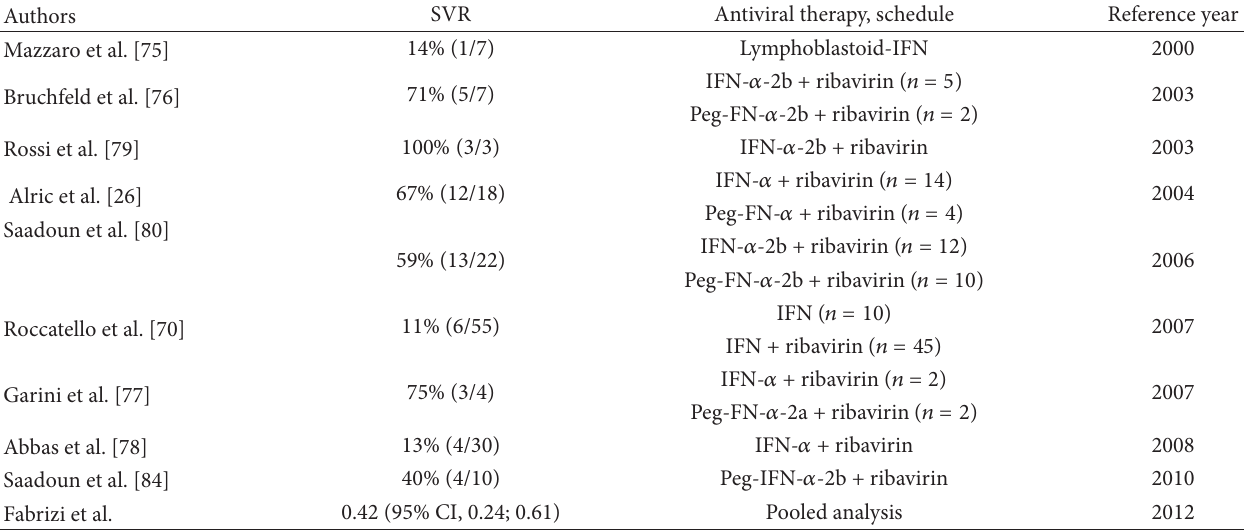
T 2: Antiviral treatment of HCV-associated GN: clinical